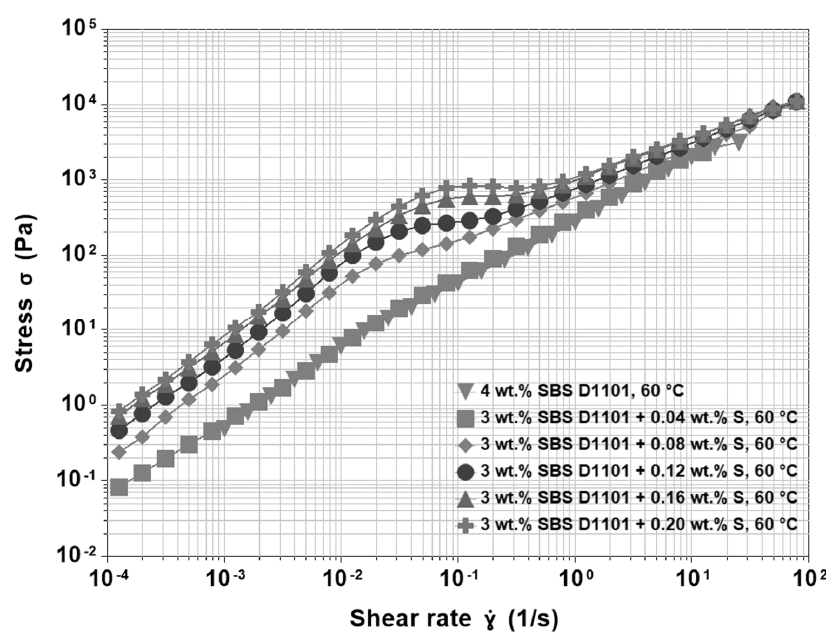
Figure 6. Shear stress as a function of shear rate at 60 °C for 200/300 Pen grade modified by 3 wt.% SBS D1101 crosslinked with sulfur ranging from 0.04 wt.% to 0.20 wt.% compared to 200/300 Pen grade modified by 4 wt.% SBS D1101 without sulfur.